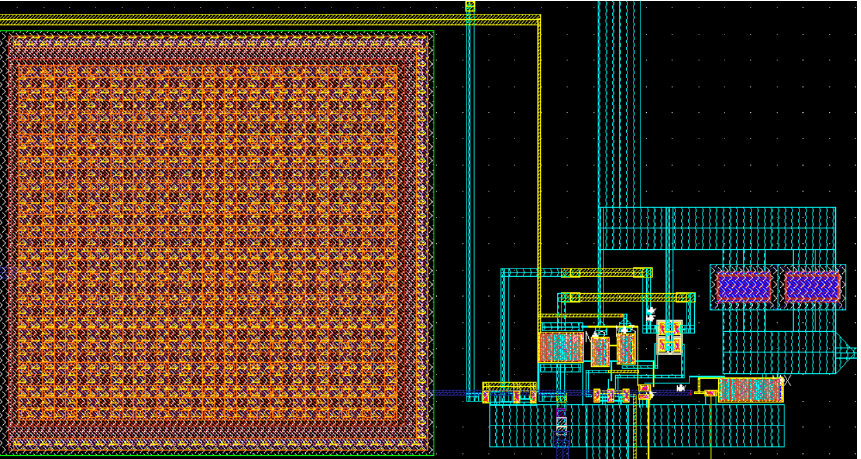
Figure 6. Physical chip layout of the proposed LNA based on current conveyors with noise cancelation (occupied area: 160 × 80 μ m 2 ).